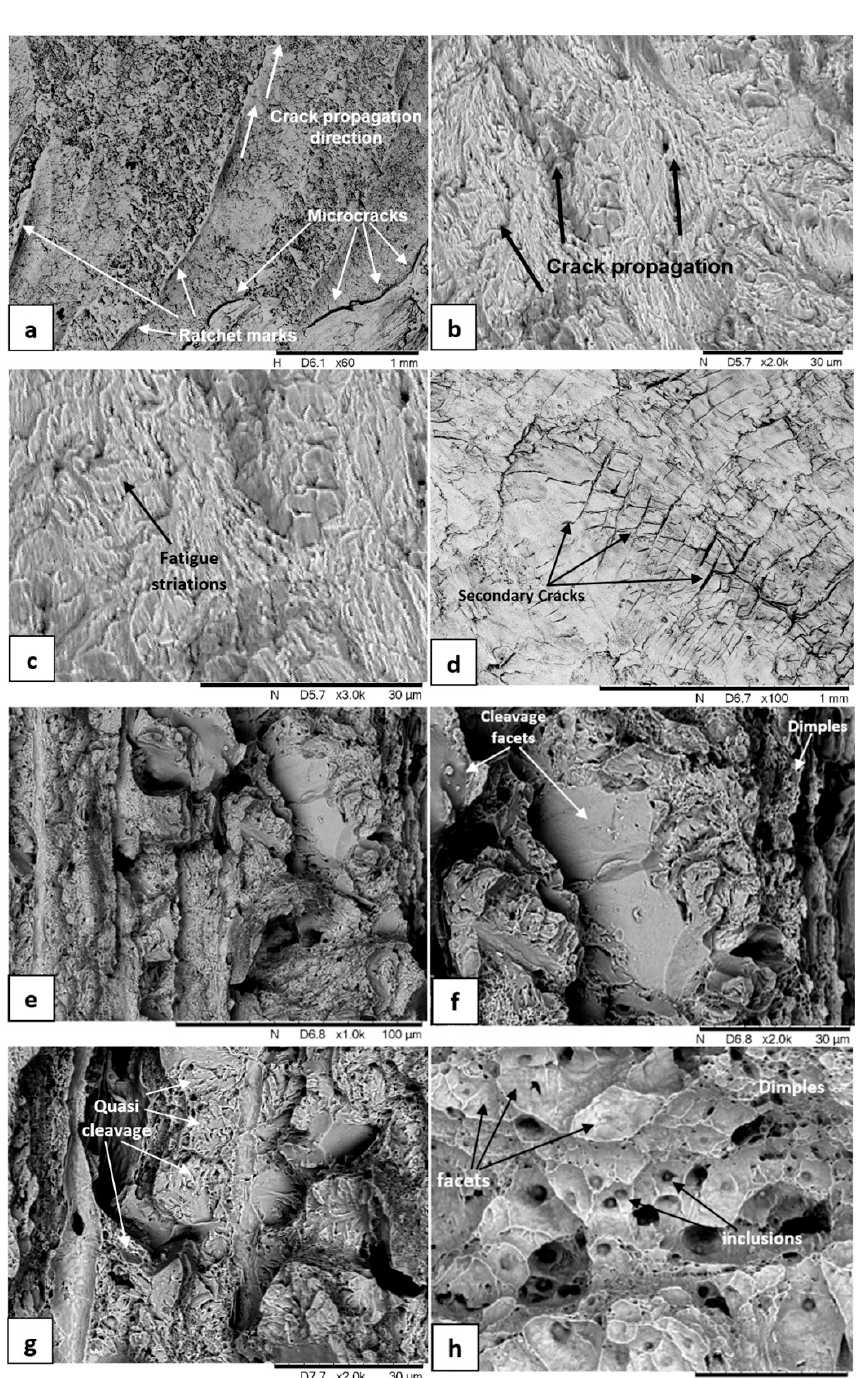
Figure 5. Fracture micromechanism: ( a ) Ratchet and microcracks brands; ( b ) fatigue propagation and striations; ( c ) detail of ( b ); ( d ) secondary crack found in zone C; ( e ) region of quasi-cleavage fracture containing traces of a fragile fracture by cleavage and dimples; ( f – h ) are details of ( e